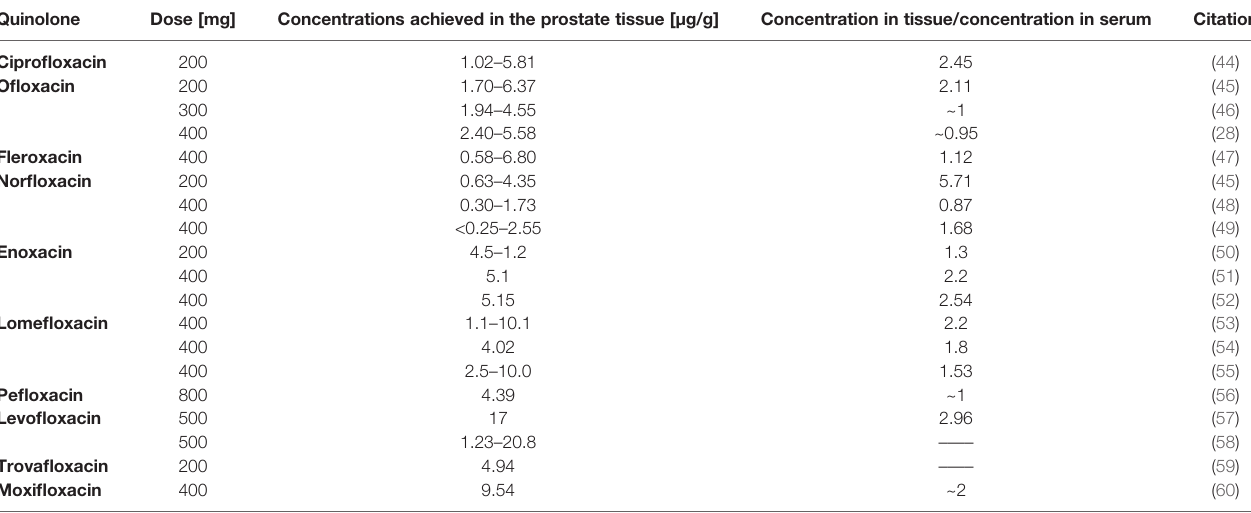
TABLE 2 | Concentrations achieved in the prostate tissue after a speci fi c dose application for individual quinolones. Quinolone Dose [mg]